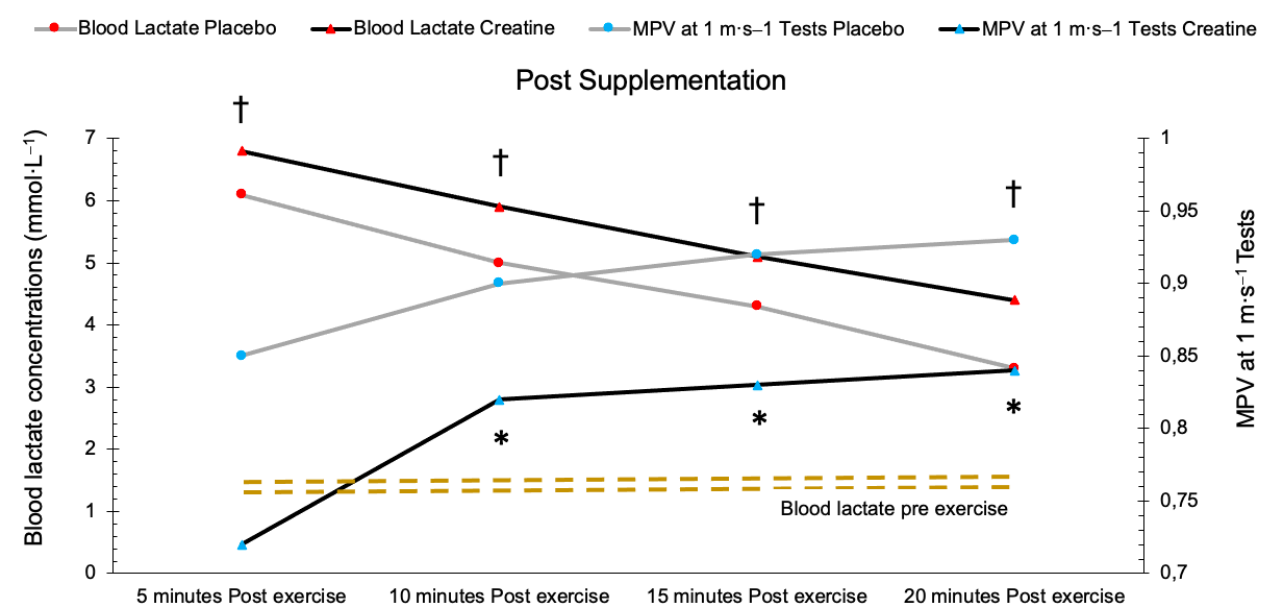
Figure 6. Relation between blood lactate concentration and MPV at 1 m · s − 1 between the groups in the post-exercise period after the supplementation period. * = significant difference in the MPV at 1 m · s − 1 test ( p < 0.05), † = significant difference in blood lactate ( p < 0.05). MPV = Mean Propulsive Velocity.